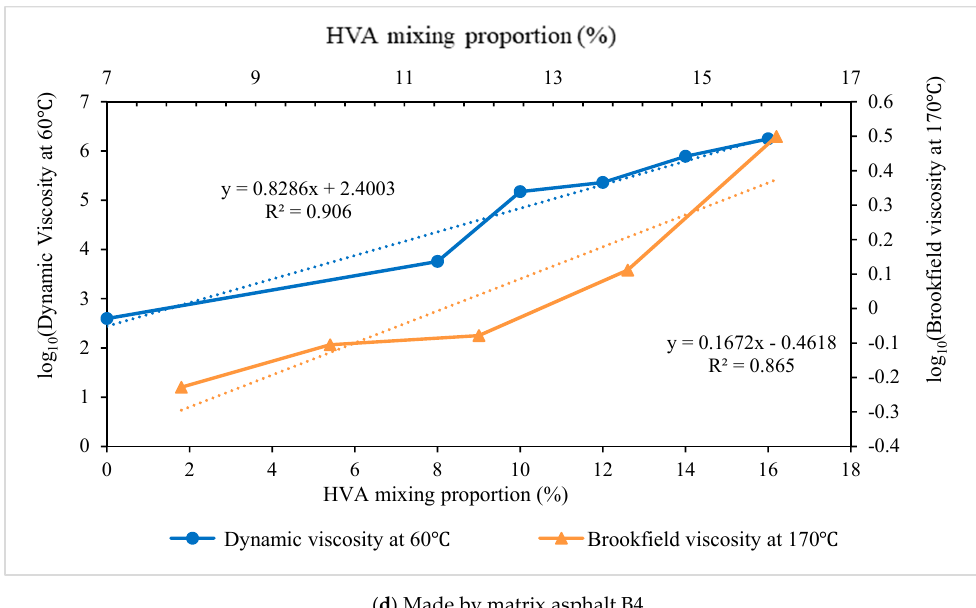
Figure 5. Dynamic viscosity and Brookfield viscosity for different HVA mixing proportion. According to analysis in Section 2.3, Brookfield viscosity at 170 °C (not more than 3.0 Pa·s) is used as an index to control maximum content of HVA and dynamic viscosity at 60 °C (not less than